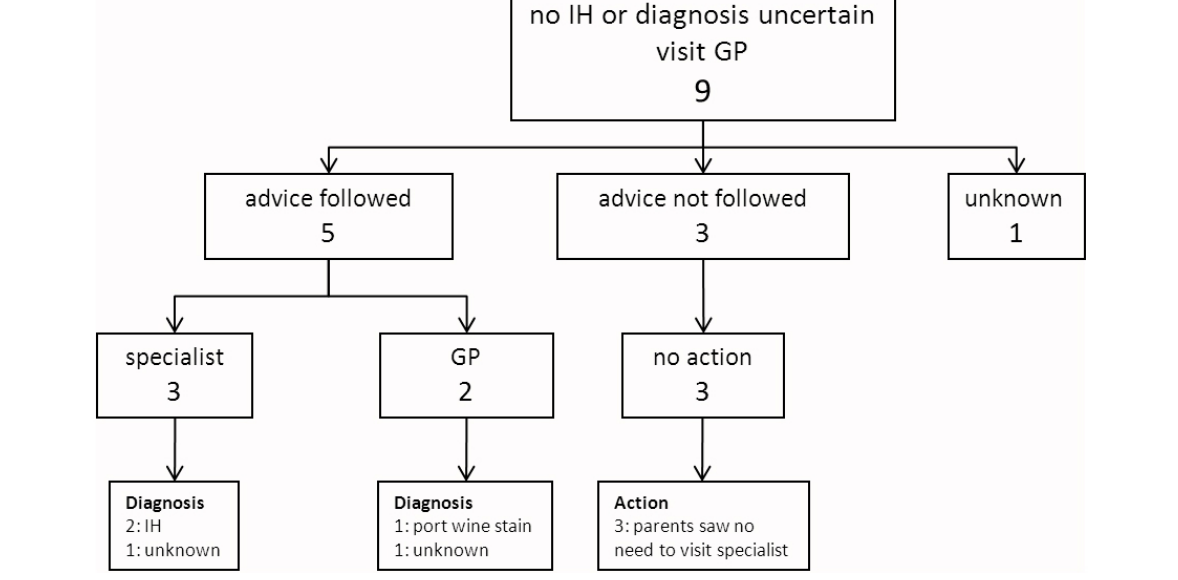
Table 3. Compliance, time between the advice and the actual appointment with a specialist, and average age of the patient, sorted by referral indication.